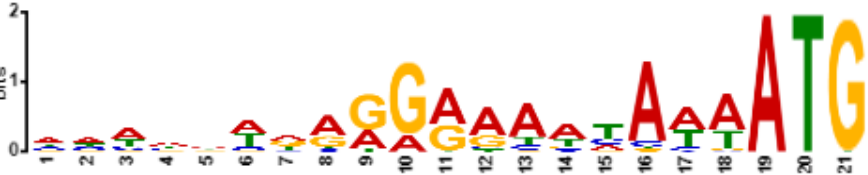
Figure 7. Shine–Dalgarno motif (ribosome binding site) in sequences of 100 bp upstream of the START codon (included) for phage Entb_45, identified by XSTREME software.